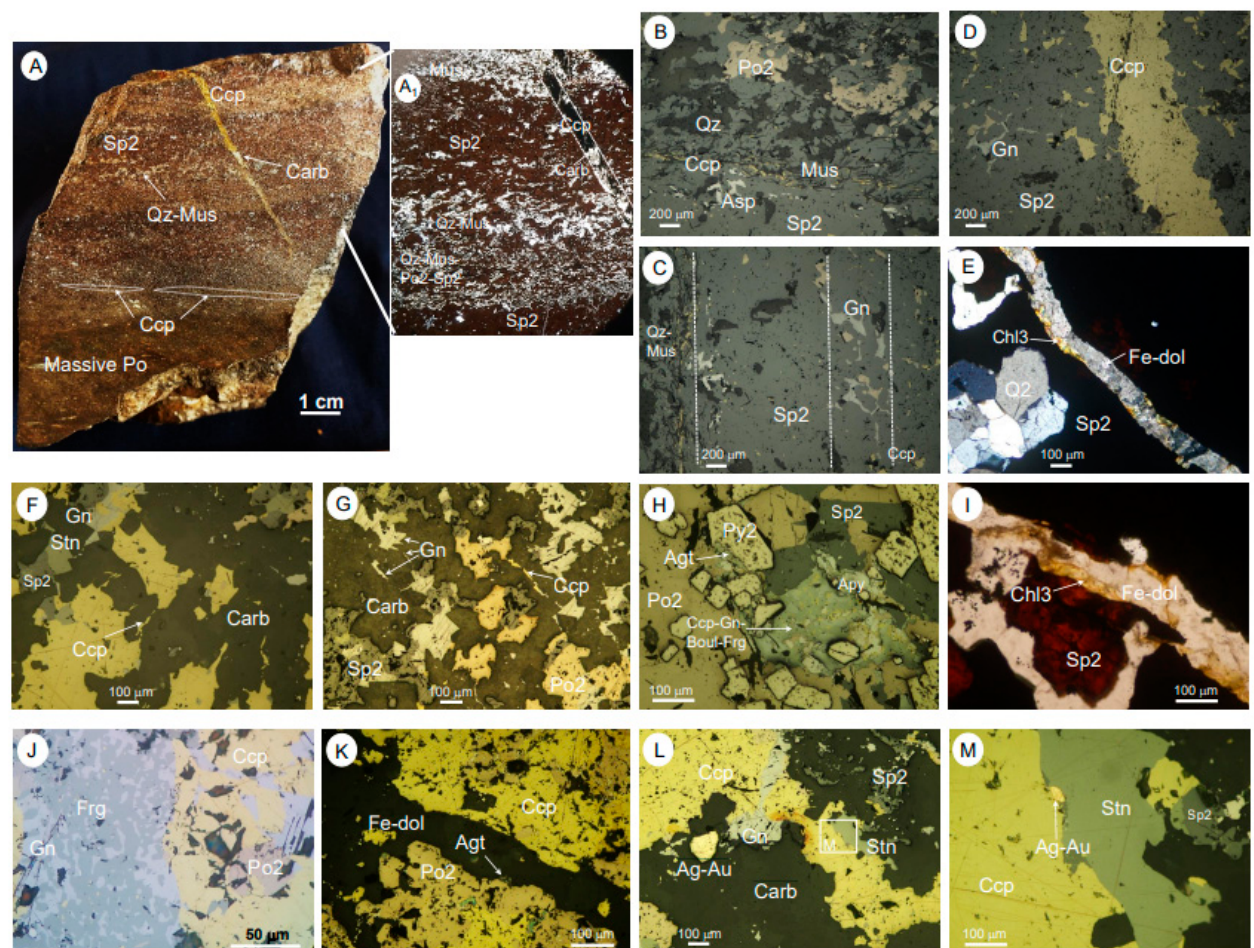
Figure 5. ( A ) Hand specimen showing banded sphalerite-rich ore with alternations of layers of pyrrhotite, quartz–muscovite, and thinner layers of late chalcopyrite and galena, with a crosscutting carbonate–chalcopyrite veinlet. ( A 1 ) Detail of ( A ) observed with binocular viewing. Optical microscope observations: ( B – D ) Details of ( A ). ( E ) Quartz 2 associated with sphalerite 2 crosscut by